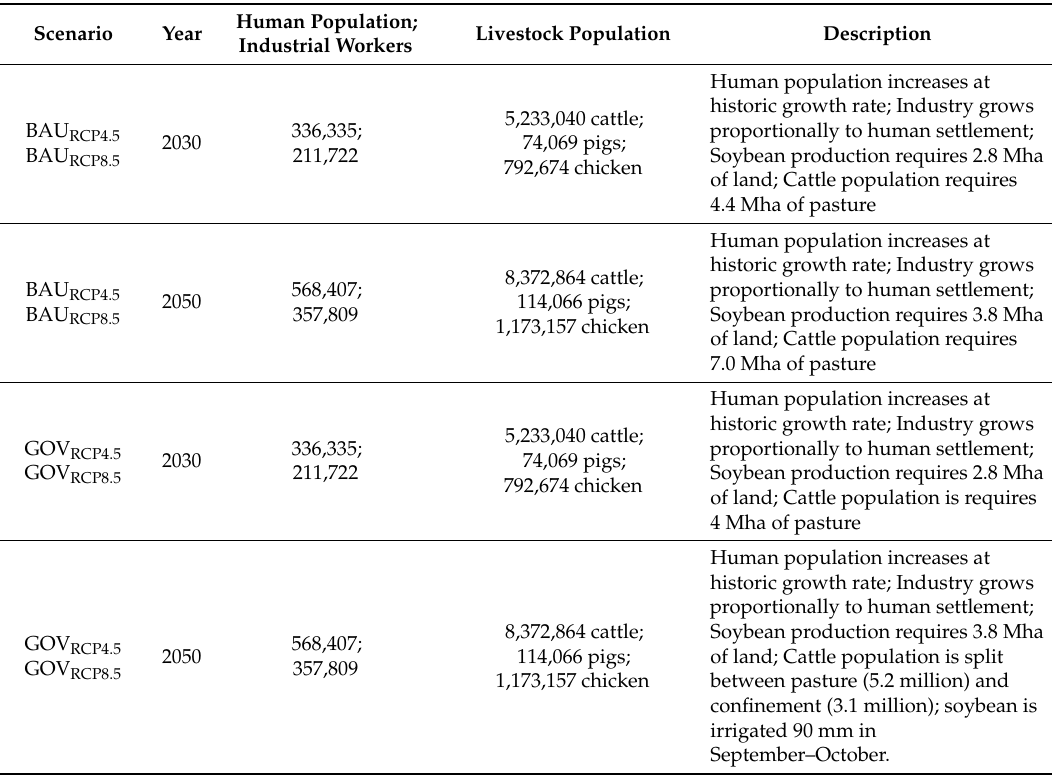
Table 1. Description of scenarios for 2030 and 2050 activities in the Xingu Basin of Mato